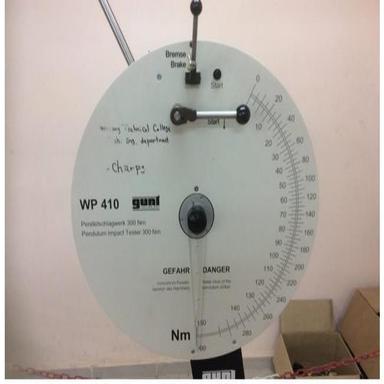
impact devise.